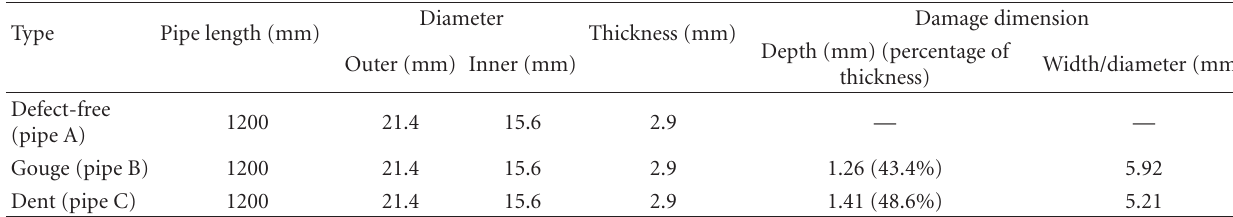
Table 1: Di ff erent types of pipe defects and their dimensions.